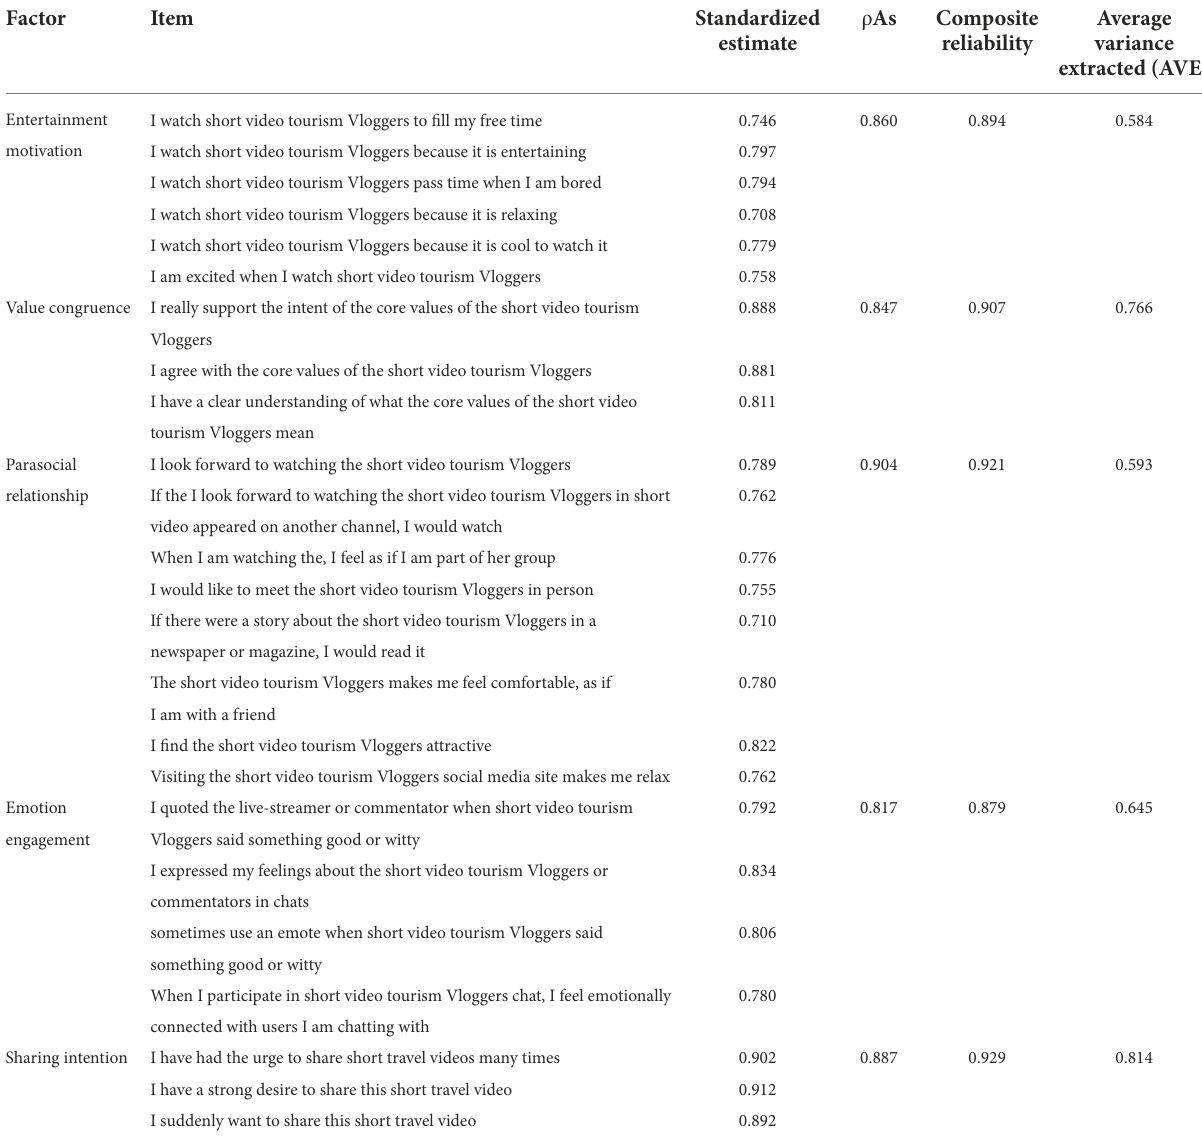
TABLE 2 Results of confirmatory factor analysis. Factor